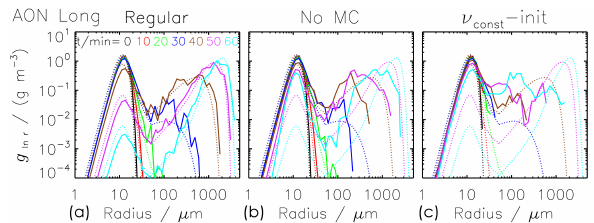
Figure 17. Mass density distributions obtained by AON for the Long kernel from t 0 to 60min every 10min (from black to cyan; = see legend). The dotted curves show the reference solution; the solid curves show the AON simulation results (ensemble averages over 50 realisations). The default settings are probabilistic singleSIP-init with weak threshold η 10 − 9 , κ 40 and (cid:49)t 1s. The left panel = = = shows results of the regular algorithm, the middle panel shows those of a version disregarding multiple collections at (cid:49)t 10s and the = right panel shows results for ν const -init with N SIP =